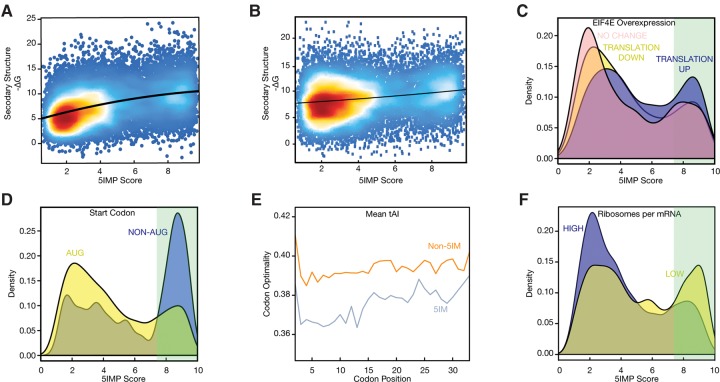
5IM transcripts have sequence features associated with lower translation efficiency. (A) The 5IM classifier score was positively correlated with the propensity for mRNA structure preceding the start codon (−ΔG) (Spearman ρ = 0.39; P < 2.2 × 10−16). For each transcript, 35 nt immediately upstream of the AUG were used to calculate −ΔG (Materials and Methods). (B) The 5IM classifier score was positively correlated with the propensity for mRNA structure near the 5′cap (−ΔG) (Spearman ρ = 0.18; P = 7.9 × 10−130; Materials and Methods). (C) Transcripts that are translationally up-regulated in response to eIF4E overexpression (Larsson et al. 2007) (blue) were enriched for higher 5IMP scores. Light green shading indicates 5IMP scores corresponding to 5% FDR. (D) Transcripts with non-AUG start codons (blue) exhibited significantly higher 5IMP scores than transcripts with a canonical ATG start codon (yellow). (E) Higher 5IMP scores were associated with less optimal codons (as measured by the tRNA adaptation index, tAI) for the first 33 codons. For all transcripts within each 5IMP score category (blue, high; orange, low), the mean tAI was calculated at each codon position. Start codon was not shown. (F) Transcripts with lower translation efficiency were enriched for higher 5IMP scores. Transcripts with translation efficiency one standard deviation below the mean (“LOW” translation, yellow) and one standard deviation higher than the mean (“HIGH” translation, blue) were identified using ribosome profiling and RNA-seq data from human lymphoblastoid cell lines (Materials and Methods).